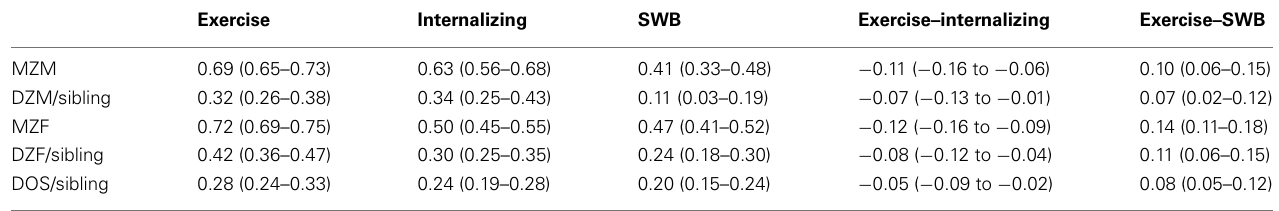
Table 2 |Twin and twin-sibling correlations for exercise behavior, internalizing problems and SWB, and the cross-twin cross-trait and cross-sibling cross-trait correlations of exercise behavior, internalizing problems, and subjective